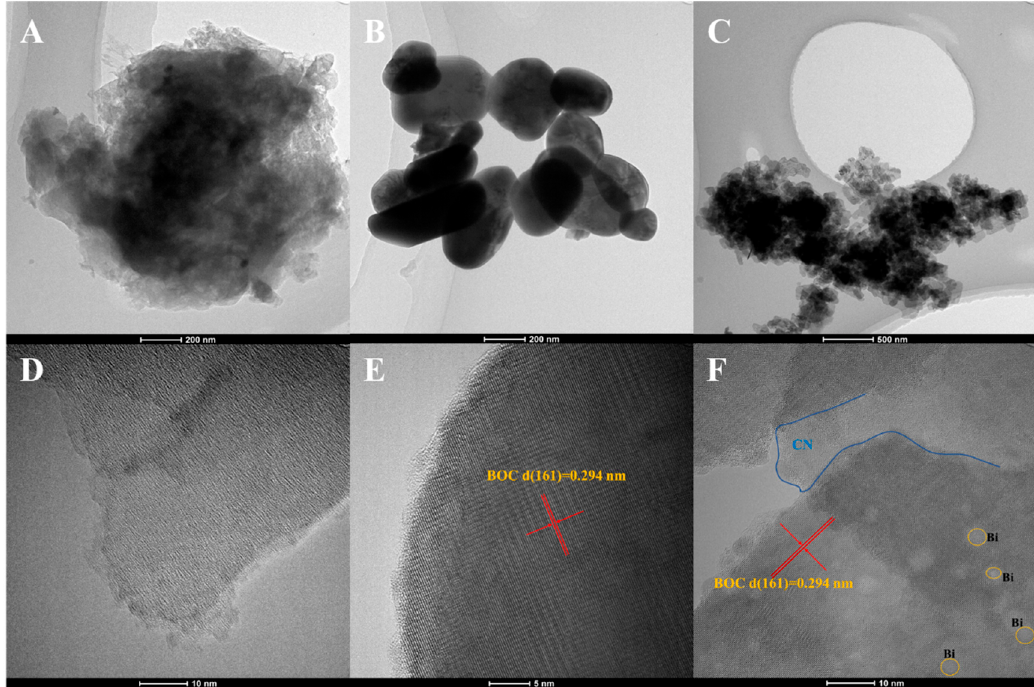
Figure 2. The TEM and HRTEM of CN ( A , D ), BOC ( B , E ) and BOC-CN-Bi ( C , F